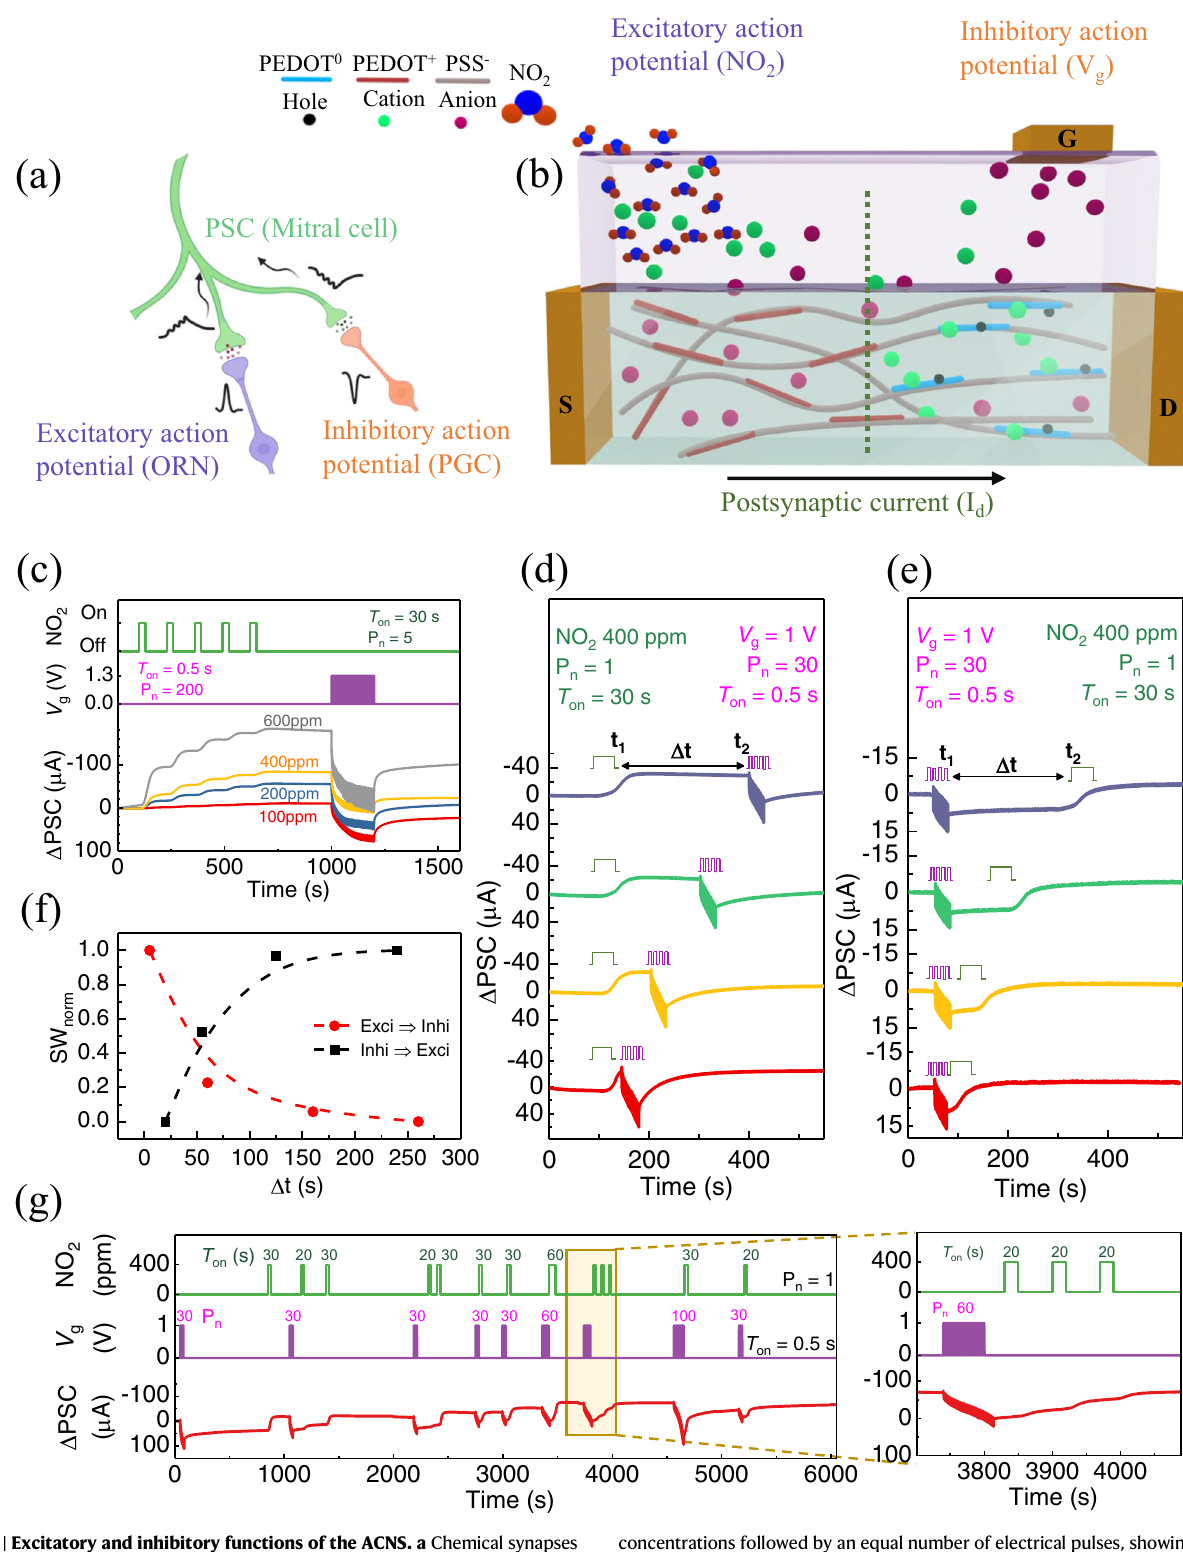
concentrations followed by an equal number of electrical pulses, showing poten- tiation fi rst and then inhibition functions. The changes in PSC with ( d ) excitatory followed by inhibitoryand ( e )inhibitorystimulifollowed byanexcitatorystimulus withdifferenttimeintervals( Δ t)betweenthetwo typesof stimuli.Theconsequent normalized SW is calculated and presented in ( f ). g Under random excitatory and inhibitory stimuli, the ACNS shows gradual modulation in the Δ PSC according to the time and number of applied